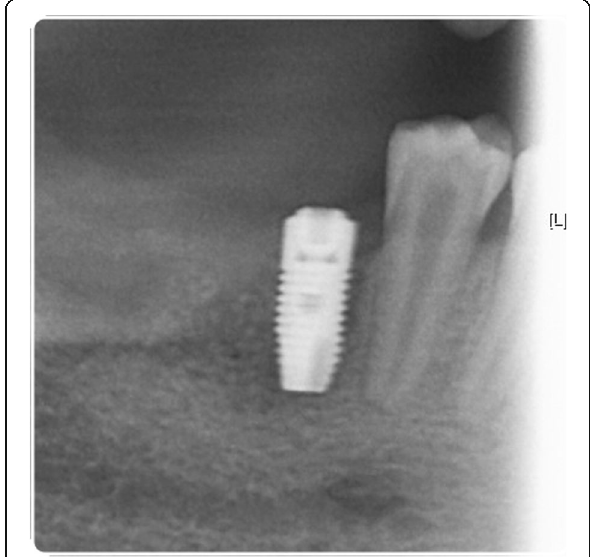
Fig. 11 Most recent fixture radiograph. Radiograph of fixture in 46